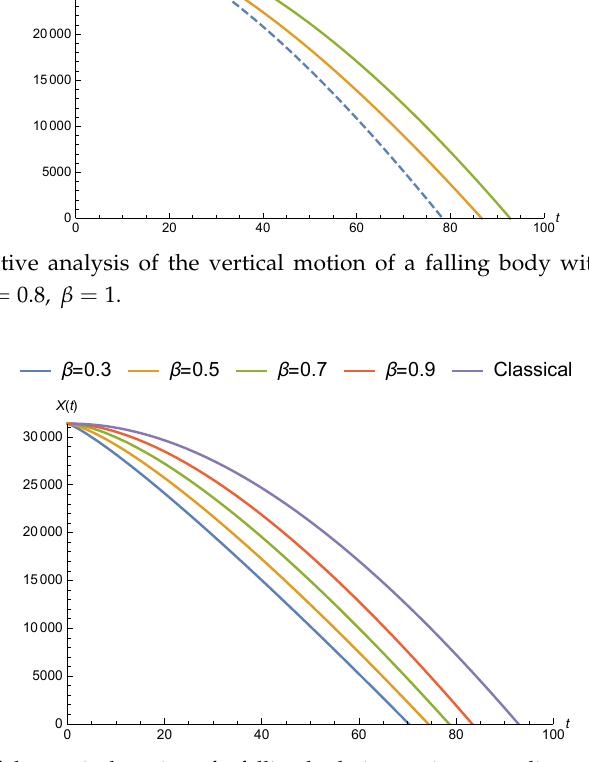
Figure 4. Analysis of the vertical motion of a falling body in a resistant medium under different orders while α =